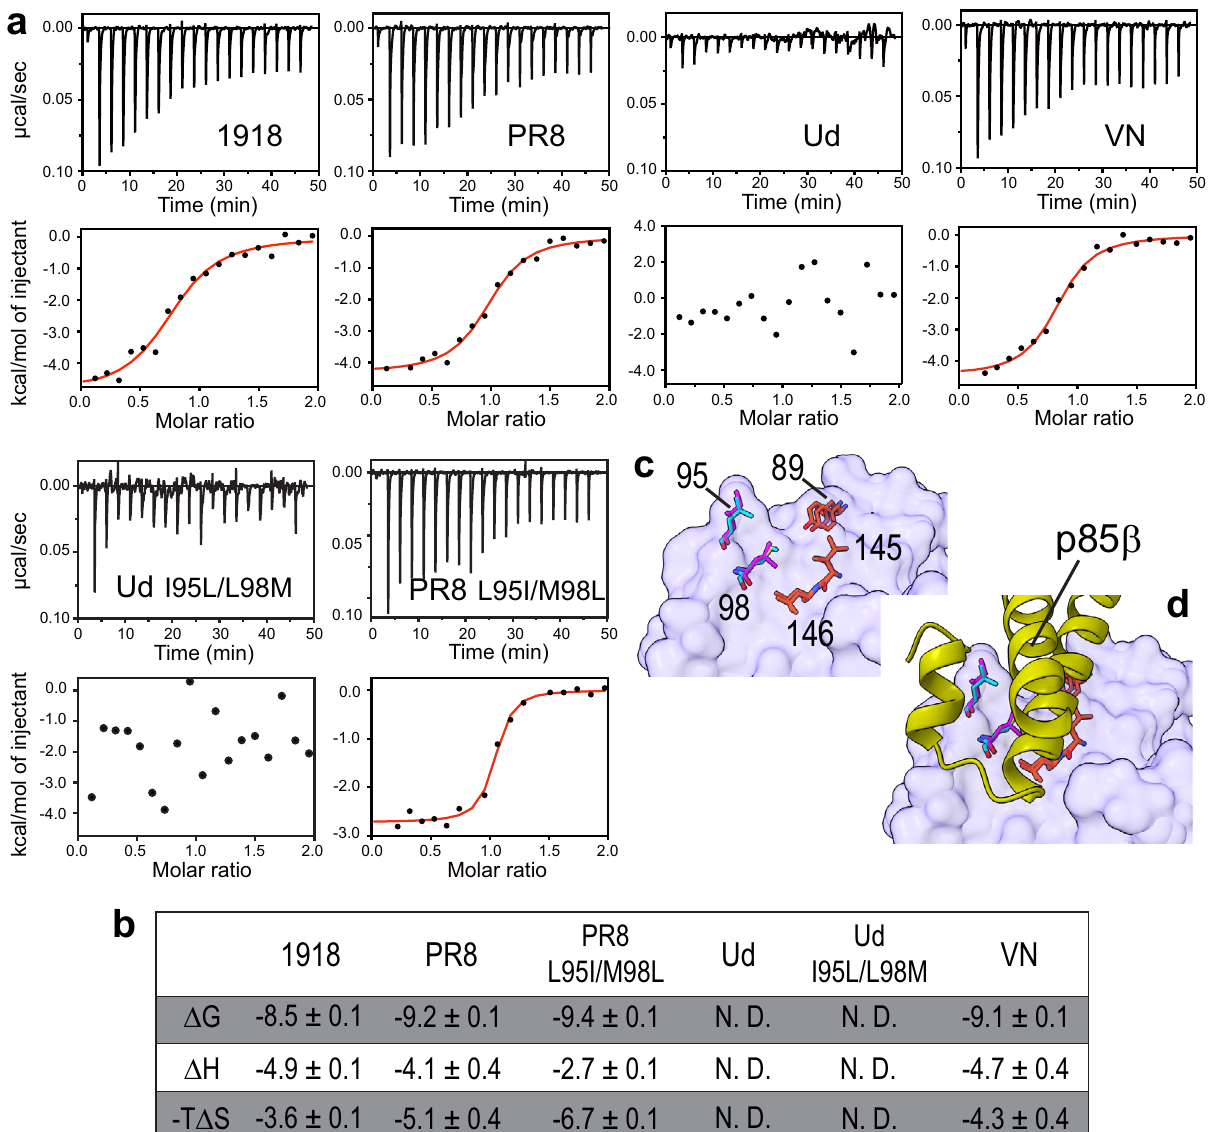
Fig. 3 | Effects of strain-speci fi c mutations of NS1s on the thermodynamic sig- nature for binding to p85 β . a ITC thermograms and binding isotherms for the interactionbetweenNS1s and p85 β . Redlines represent fi t curvesusing 1:1 binding stoichiometry. b Estimated thermodynamic parameters for binding between NS1s and p85 β . Uncertainties represent the standard deviation of three repeated